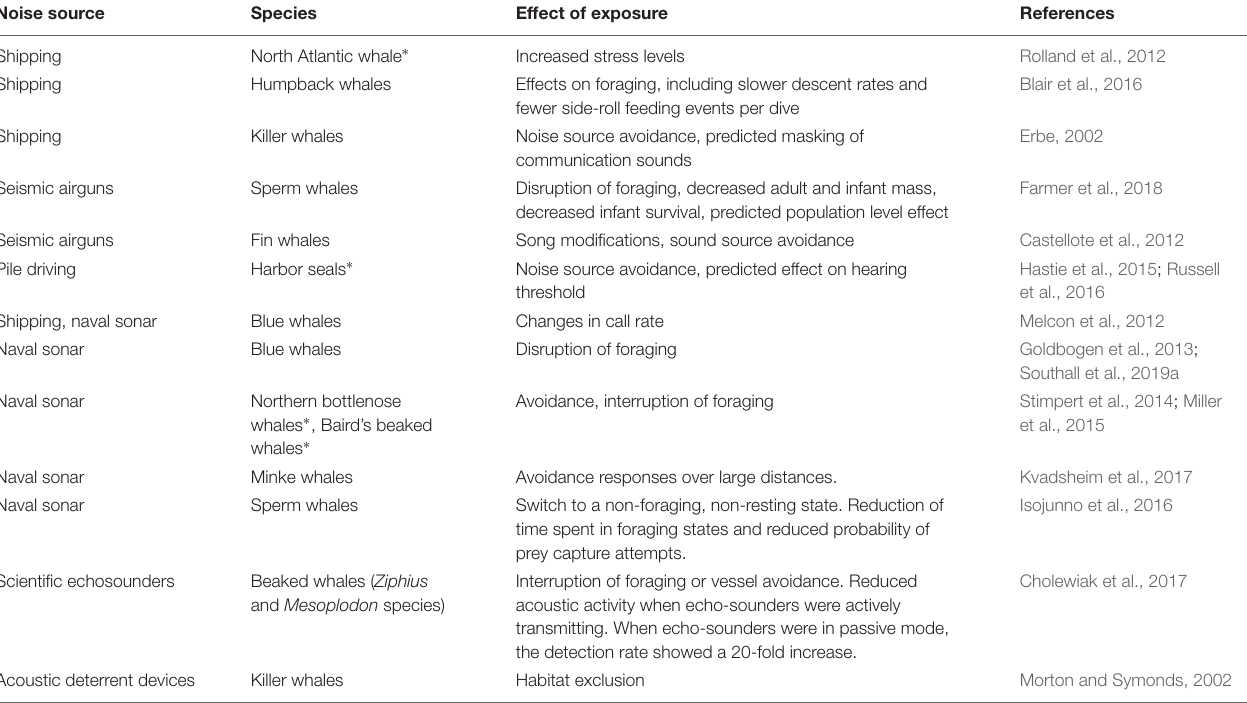
TABLE 3 | Examples of reported effects of noise on Antarctic marine mammals ( ∗ or closely related